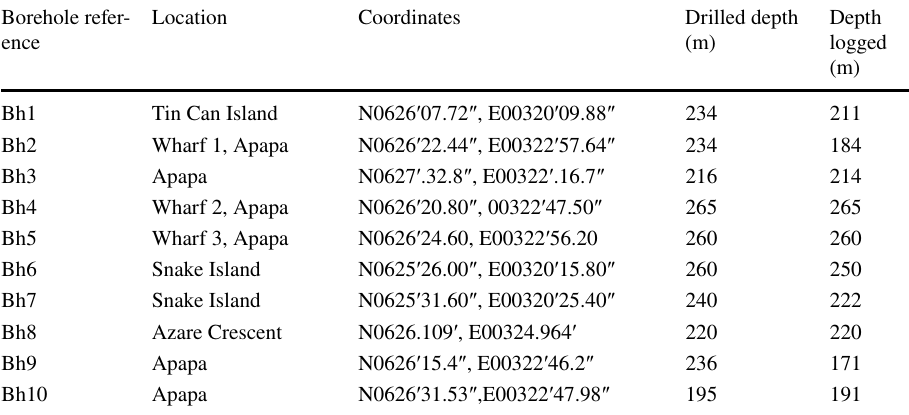
Table 1 Summary of studied boreholes in Apapa